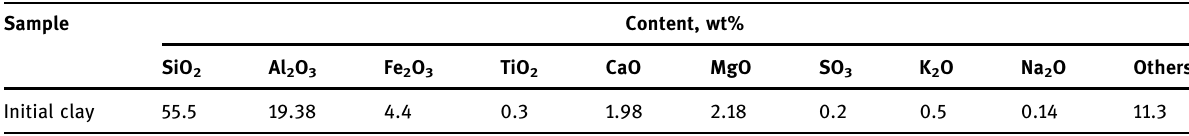
Table 1: Elemental analysis of the initial sample of montmorillonite